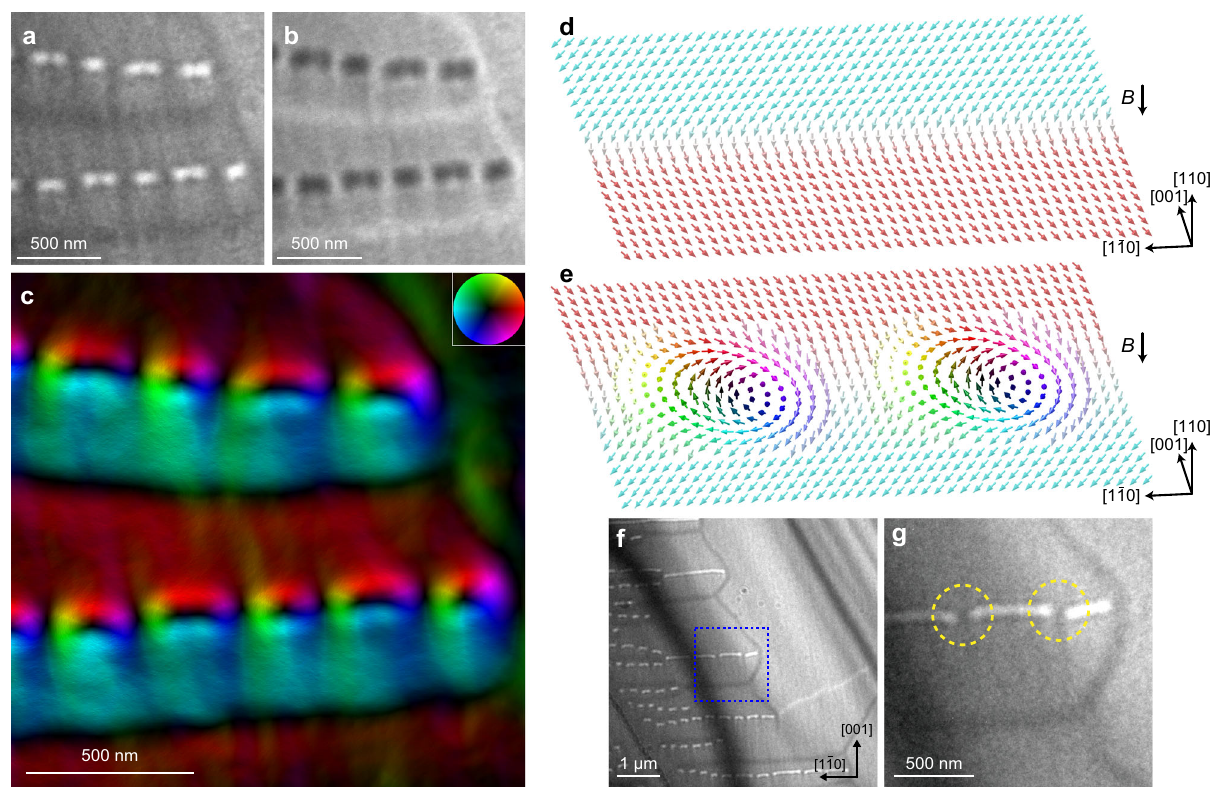
Fig. 3 Magnetic structure of DW bimerons and isolated DW bimerons. a , b Underfocused ( Δ f = − 1.5 mm) ( a ) and overfocused ( Δ f = + 1.5 mm) ( b ) LTEM images, enlarged view of the blue dotted box in Fig. 2d. The scale bars are 500 nm. c Magnetic fl ux density (magnetization) map obtained using the transport of intensity equation analysis based on a and b . The scale bar is 500 nm. The color wheel (inset) represents the orientation and magnitude of the in-plane component of magnetic fl ux density. The in-plane magnetizations on both sides of the bimeron chains have the opposite directions along the in-plane <110> directions, verifying the existence of DW bimerons. d , e Schematic illustration of DW ( d ) and DW bimerons ( e ). The arrows depict perpendicularly averaged magnetization to the plane. In the domains, average magnetization are oriented in the <100> directions of the magnetic easy axes. f Underfocused LTEM image with Δ f = − 2 mm obtained at 324 K and 190 mT. g Enlarged view of the blue dotted box in f